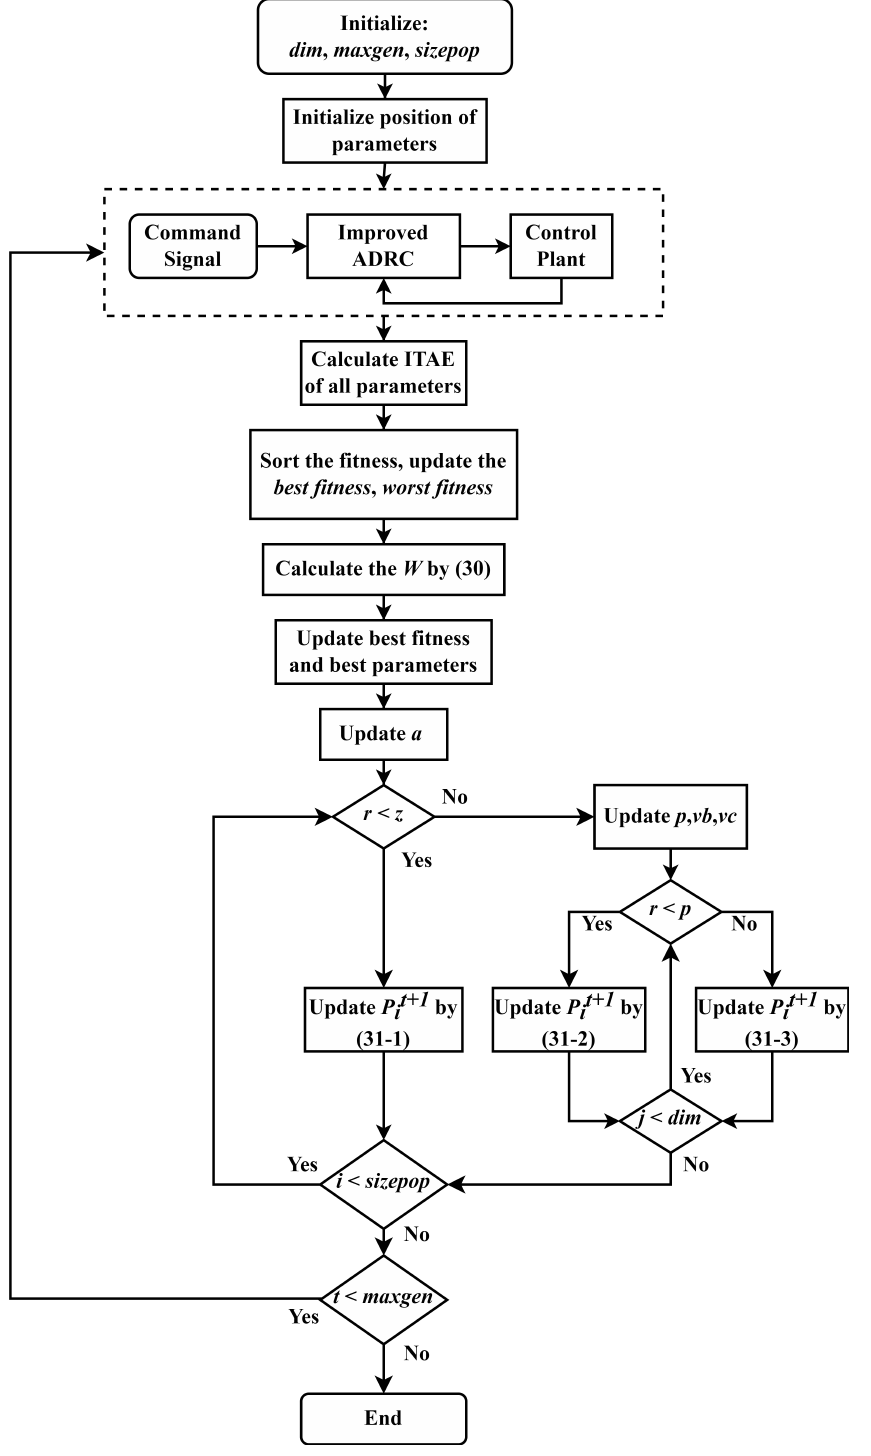
Figure 2. The flow chart of parameters tuning based on